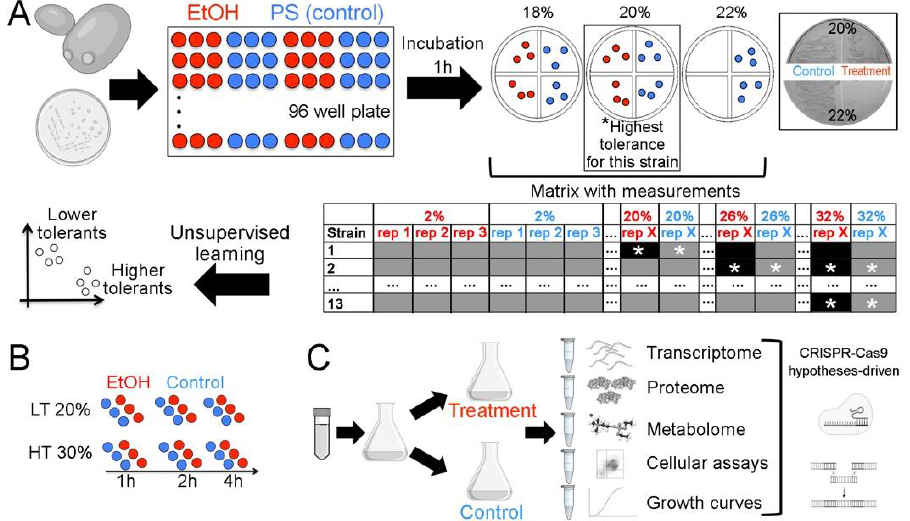
Figure 1. Experimental design. ( A ) Setting the phenotypes. PS: physiological solution; red and blue circles: treatment and control, respectively. The box shows examples of plates used to determine the highest EtOH tolerance. The experimental conditions that allowed or inhibited growth are represented by gray and black boxes, respectively. *: The highest EtOH level. ( B ) Time-course experiment. ( C ) Further experiments and hypothesis testing using mutants.